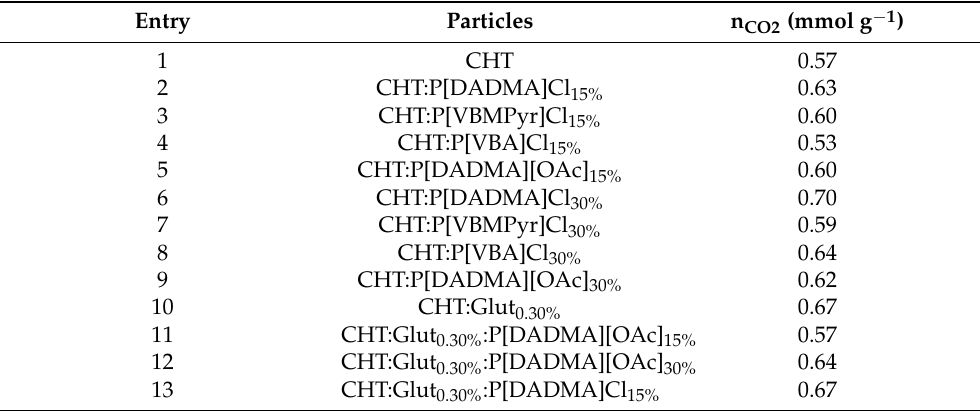
Table 4. CO 2 capture capacities of AEROPILs at 25 ◦ C and 1 bar after exposure to CO 2 for 10 min. Notation: n CO2 , CO 2 capture